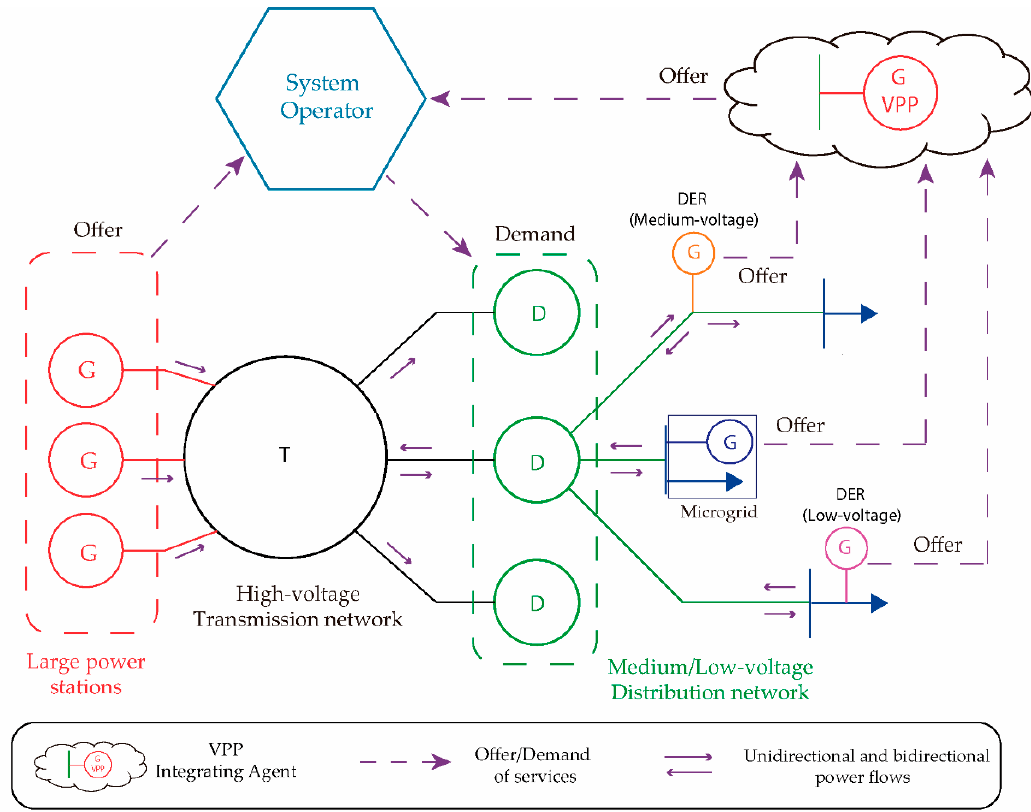
Figure 7. Centralized Operational Architecture .